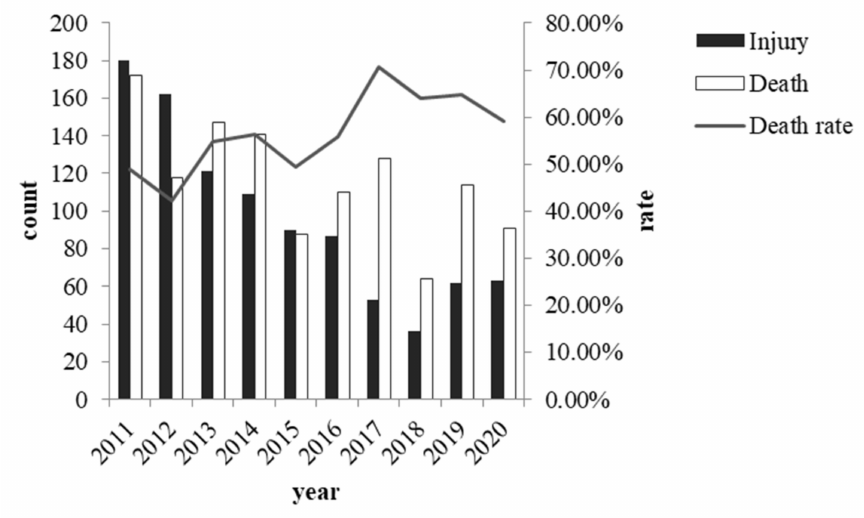
Figure 9. Occurrence of different collision severities in different